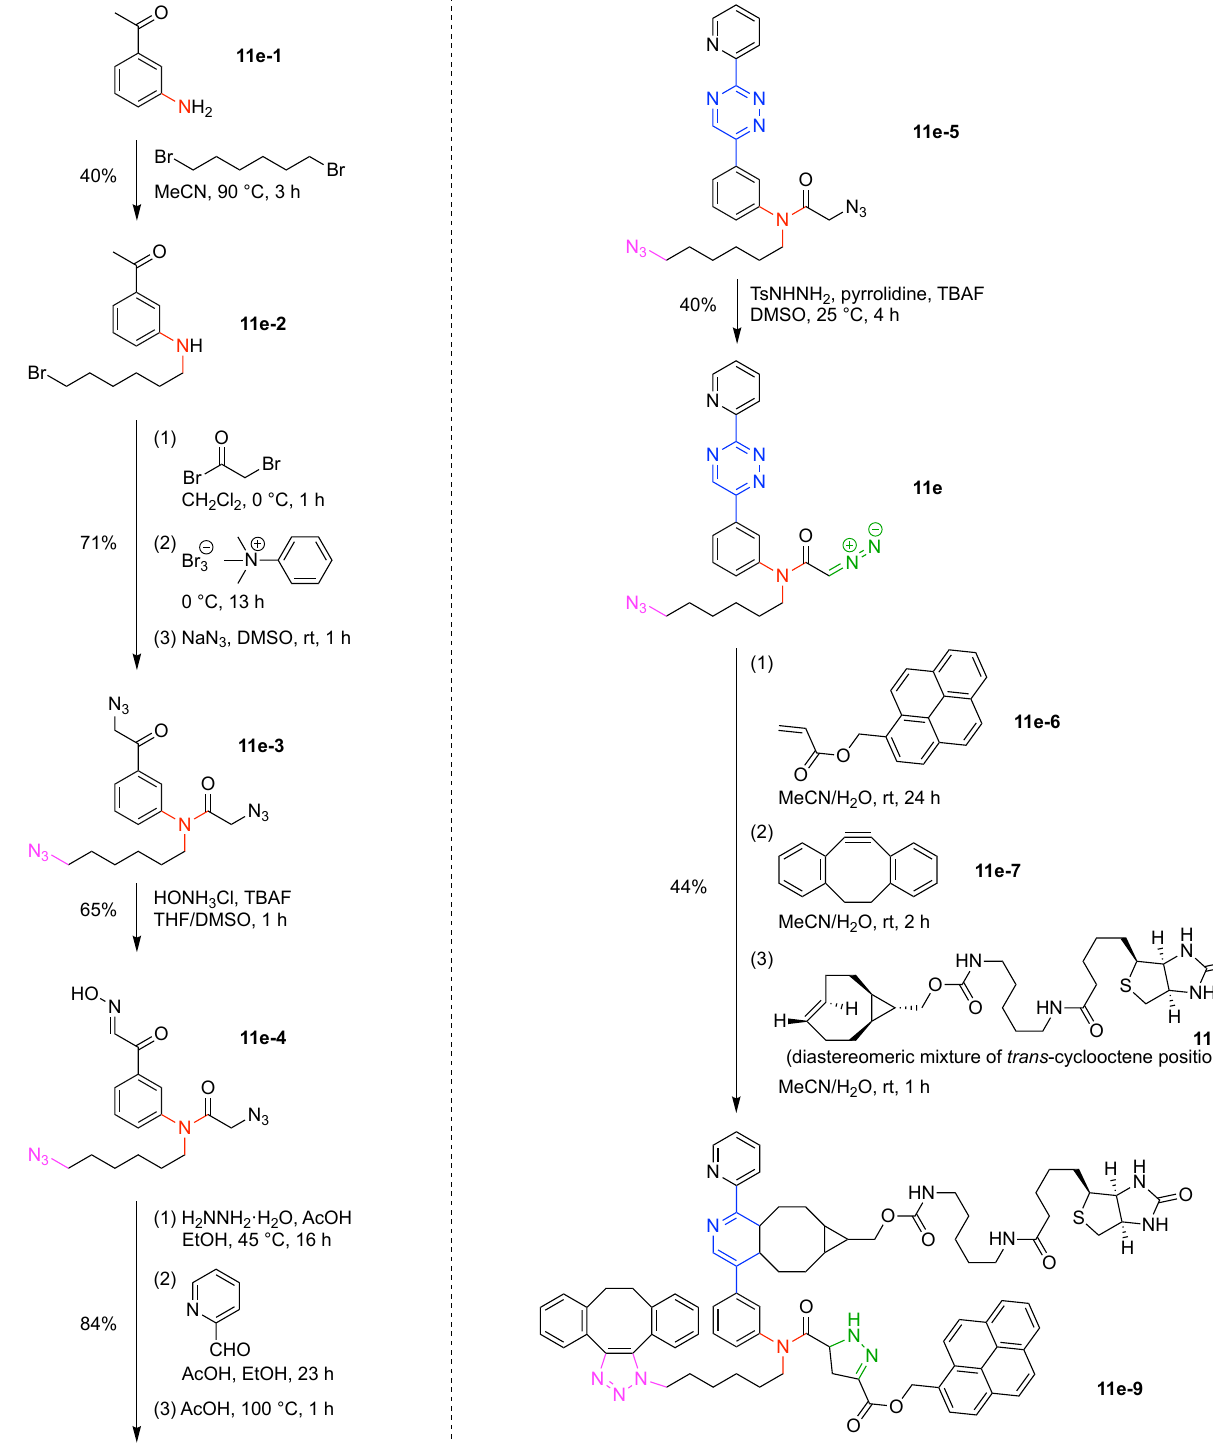
( N -terminal proline, methionine, and histidine). This construct ( 11j ) has composition A 2 B and architecture [3][1] 3 .